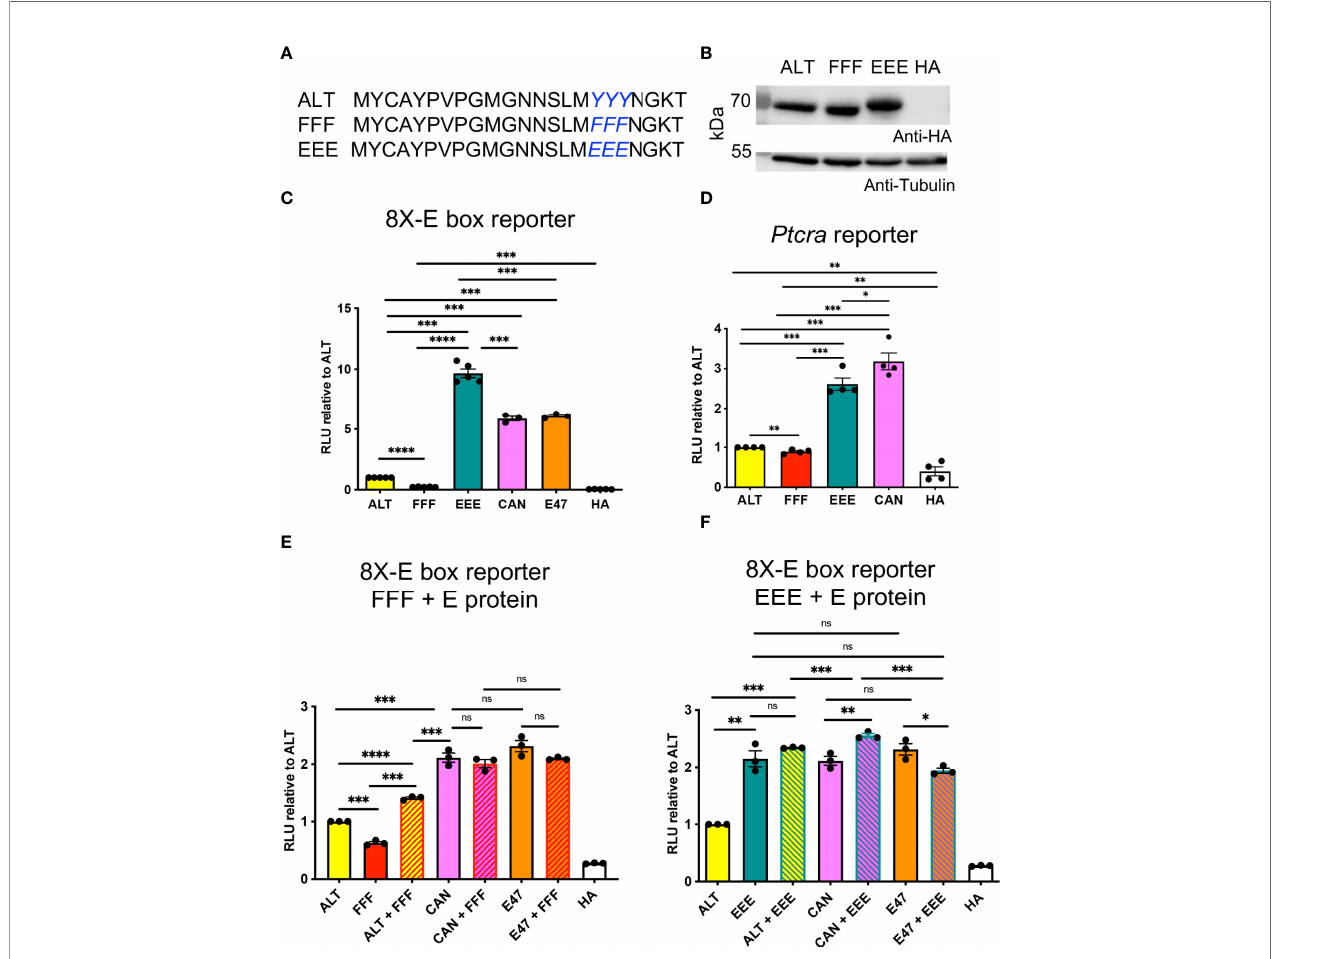
FIGURE 2 | A YYY motif in the Alt domain modulates HEBAlt transcriptional activity. (A) Amino acid sequences of the Alt domain of the EEE and FFF constructs. (B) Western blot of protein expression for the HA-tagged ALT, FFF, and EEE constructs in HEK293T cells, probed by anti-HA, with anti-tubulin as a loading control. (C) Dual luciferase assays on BMK cells transfected with expression constructs for ALT, FFF, EEE, HEBCan (CAN), E2A (E47), or HA empty vector control, along with 8X E box Fire fl y luciferase and Renilla luciferase constructs. The Y-axis depicts relative luciferase units (RLU) of Fire fl y to Renilla luciferase values, normalized to ALT. (D) Dual luciferase assay on HEK293T cells co-transfected with HA-tagged expression constructs for ALT, FFF, EEE, CAN, or HA empty vector control with a construct in which Fire fl y luciferase was driven by the Ptcra promoter, and a Renilla luciferase construct. The Y-axis depicts relative luciferase units (RLU) of Fire fl y to Renilla luciferase values normalized to ALT. (E) Constructs were mixed 1:1 to allow the formation of homodimers of ALT, CAN, E2A (E47), or FFF, or heterodimers of ALT, CAN, or E2A with FFF, and activity was measured by luciferase assays using the 8X E box construct. (F) Constructs were mixed 1:1 to allow the formation of homodimers of ALT, CAN, E2A (E47), or EEE, or heterodimers of ALT, CAN, or E2A with EEE, and activity was measured in HEK293T cells by luciferase assays using the 8X E box construct. Note that the assays shown in (E, F) were conducted at the same time, and the ALT, FFF, EEE, CAN, E47, and HA samples were graphed next to either the FFF or EEE samples for clarity. *P < 0.05, **P < 0.001, ***P < 0.0001, ****P < 0.0001, ns, non-signi fi